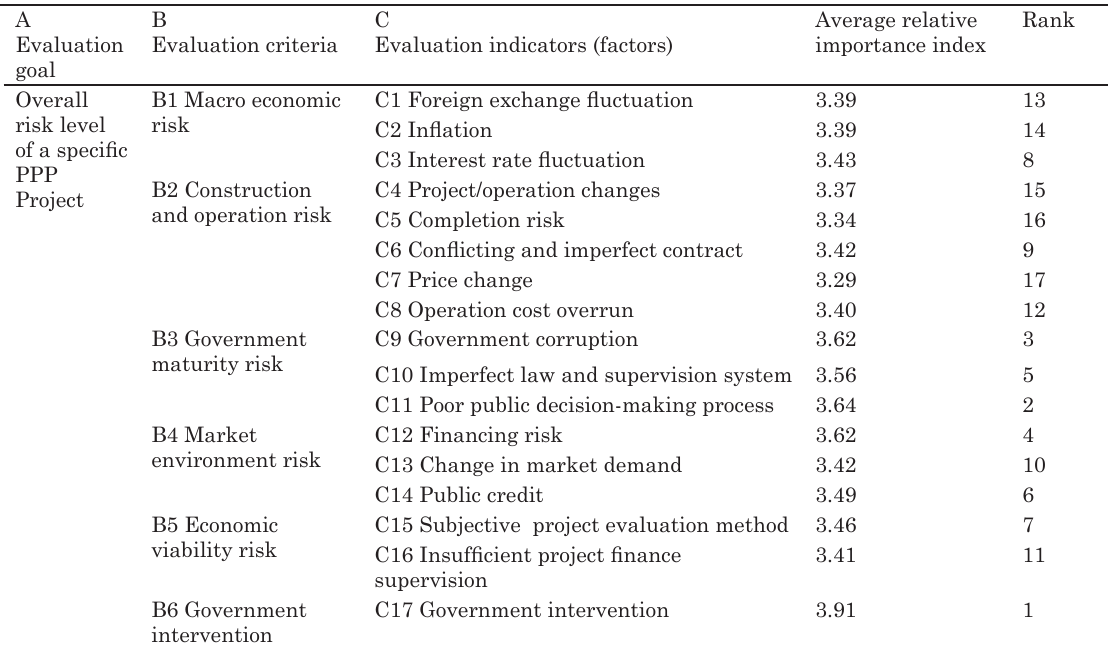
table 2. risk evaluation structure of PPP projects in china a evaluation